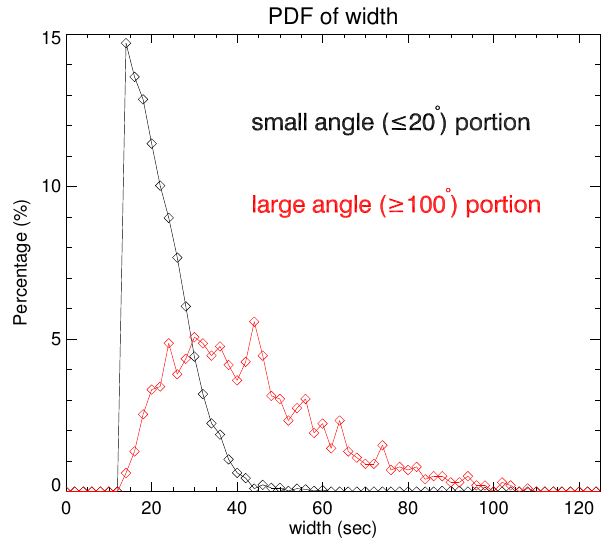
Fig. 7. Width of current sheet of all 28214 cases. The y-axis is the normalized number of occurrences of current sheet in log scale; the x-axis is width of current sheet, unit is second. The black curve is the potion with 1θ < 20 ◦ ; the red curve is the potion with 1θ > 100 ◦ .